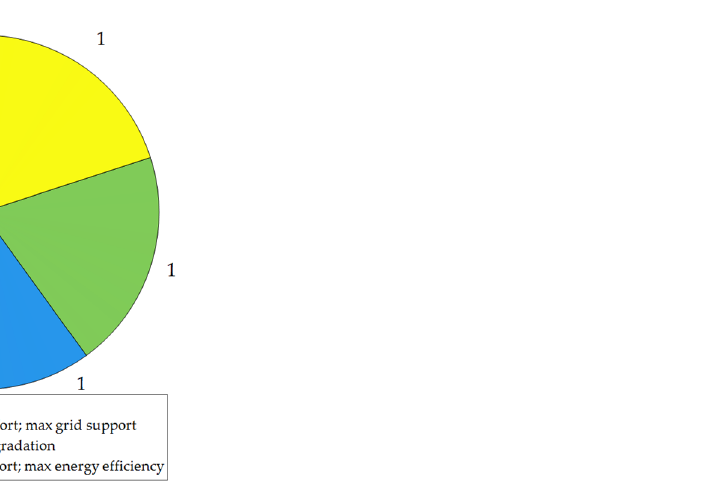
Figure 9. Number of selected papers associated with a given objective for model predictive control.